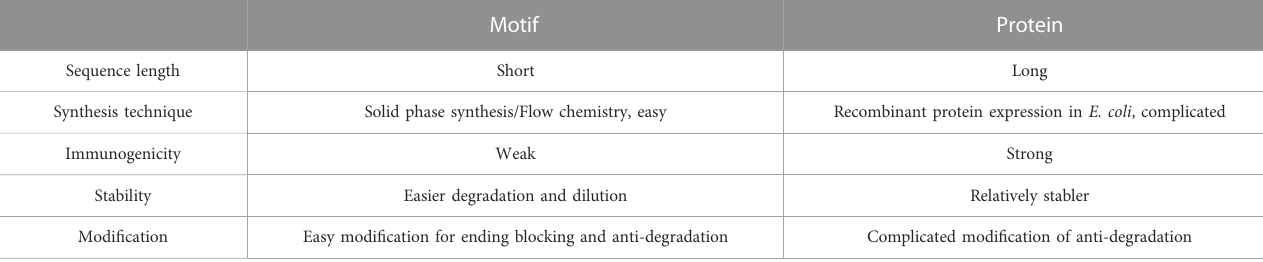
TABLE 2 Characteristics of motifs and